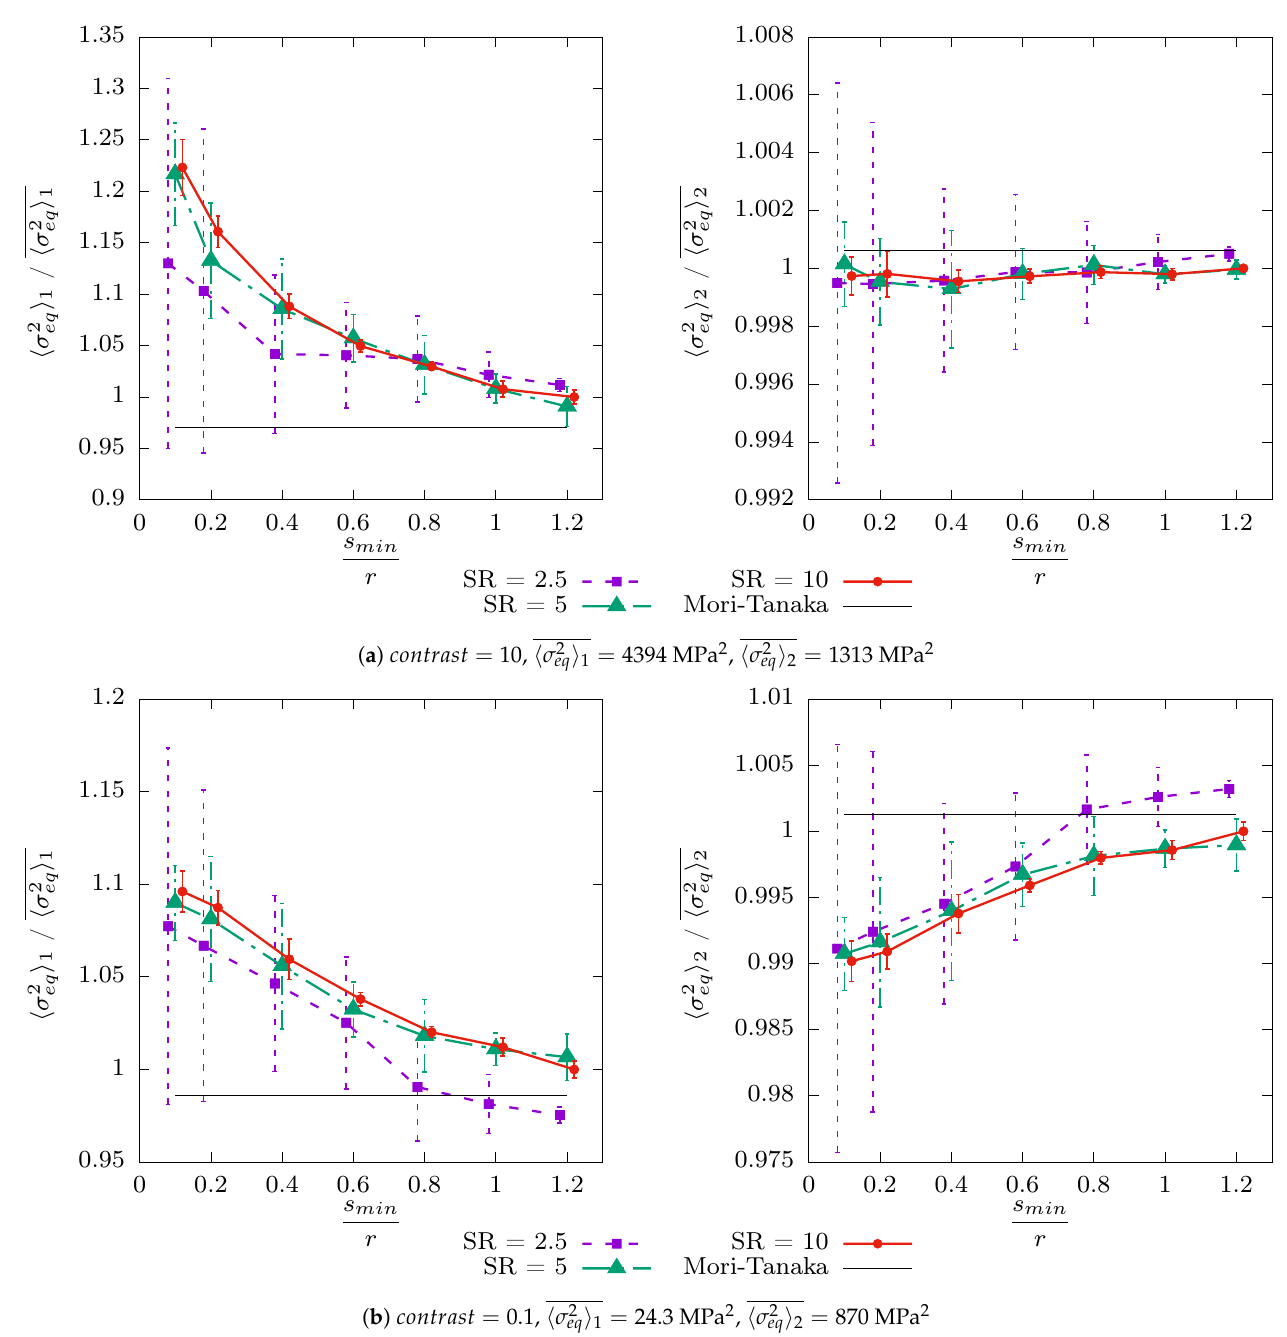
Figure A8. Mean values and standard deviations on the mean value for the second moment of equivalent stress by phase as a function of the packing parameter s min / r ( r = 10 µ m) for a volume fraction of inclusions f v = 13.4 %. For clarity, the error bars and dots are slightly shifted around for each studied minimum